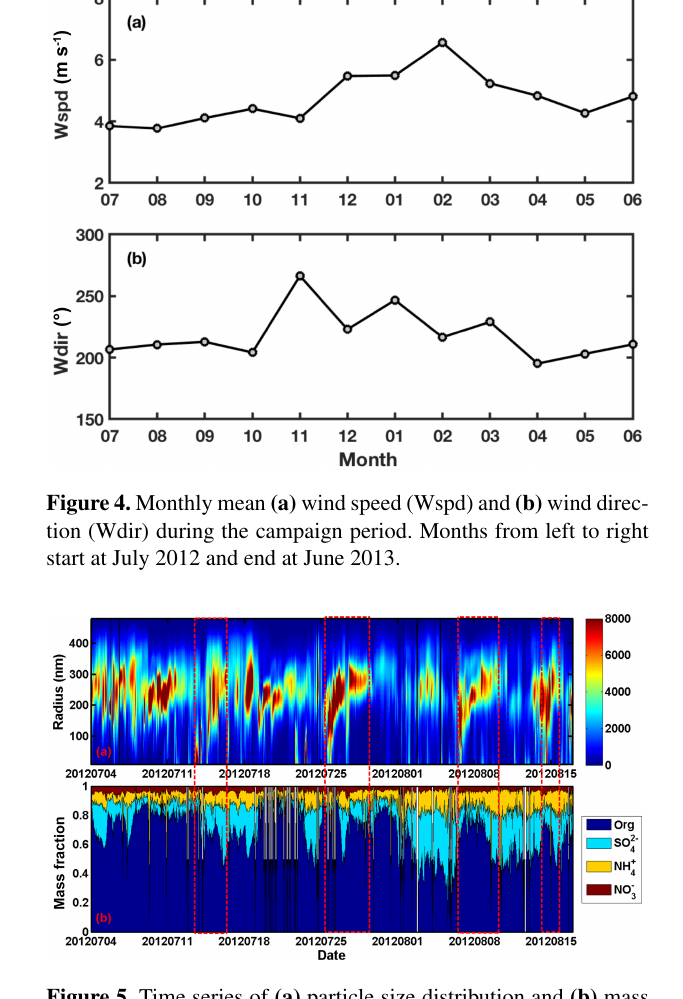
Figure 5. Time series of (a) particle size distribution and (b) mass fractions of organics (org, dark blue), sulfate (SO 2 − , cyan), ammo- 4 , red) in aerosols sampled nium (NH + , yellow), and nitrate (NO − 4 3 during July and August of 2012. Dashed red rectangles outline pe- riods of new particle formation and